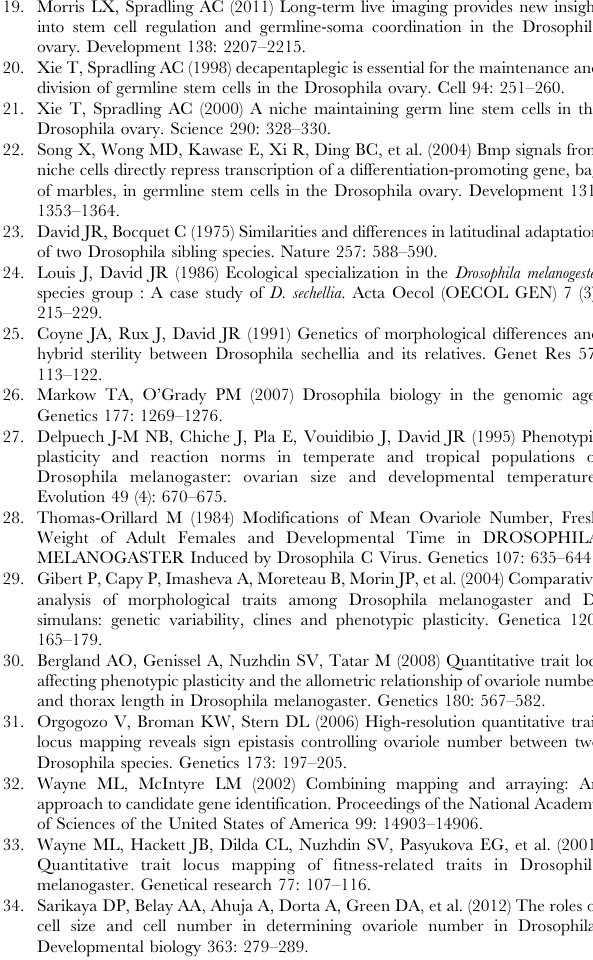
psq 0115 /psq D 18 ovary. The position of molecular weight markers (Biorad) is indicated on the left of the pannel. Figure S2 Number of dividing cells in wild type Canton- S ( + ) and psq 0115 / + ; bab P / + in ovaries from wandering larvae. Mitotic figures were revealed using anti phospho-histone H3 (Ser10) antibody on whole mount ovaries. Confocal 3D projections was used to count mitotic cells in 10 ovaries for each phenotype. Table S1 Statistical significance (p) of comparisons between the mean number of ovarioles in heterozygous combinations of psq, Trl and batman alleles and that of wild type control flies. Table S2 Statistical significance of comparisons be- tween the mean number of ovarioles in bab . psqIR flies and in control flies. Table S3 Statistical significance of comparisons be- tween the mean number of ovarioles in combinations of bab and other ttk-BTB group mutations.